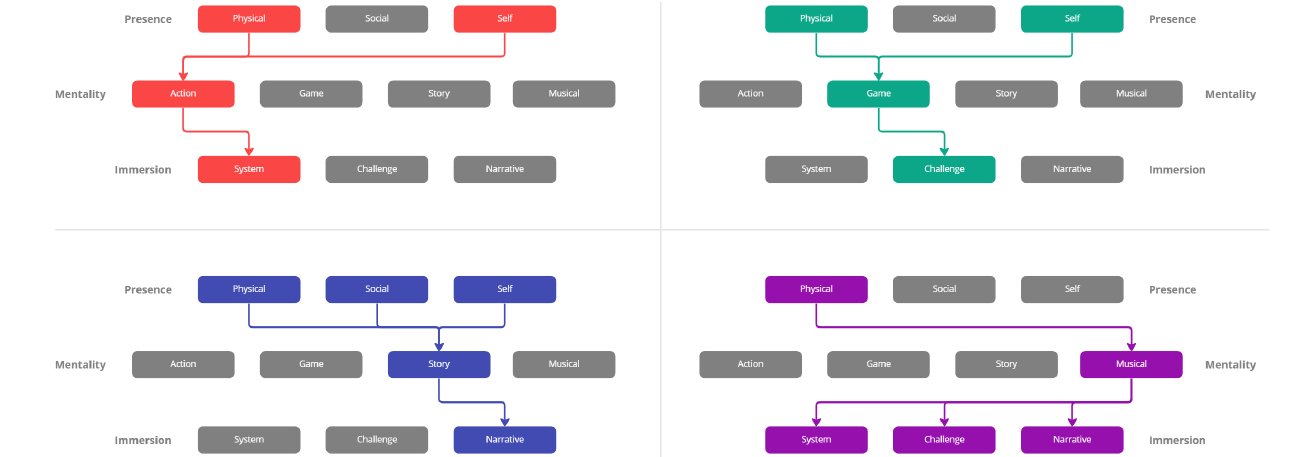
Figure 6. Mappings between presence (after Lee, 2004) and immersion (after Nilsson et al., 2016) for each of the four mentalities identified in our analysis of Beat Saber and Ragnarock: Action, Game, Story,